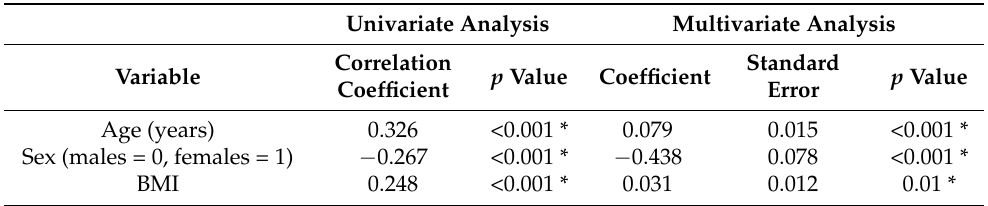
Table 3. Results of simple correlation and multiple regression analysis between AL and variables ( n =